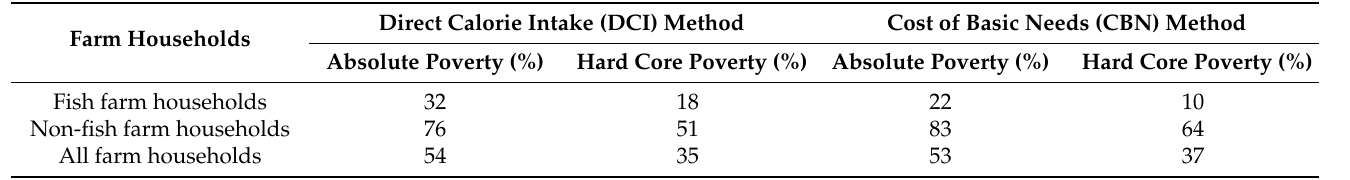
Table 8. Poverty indexes of fish and non-fish farm